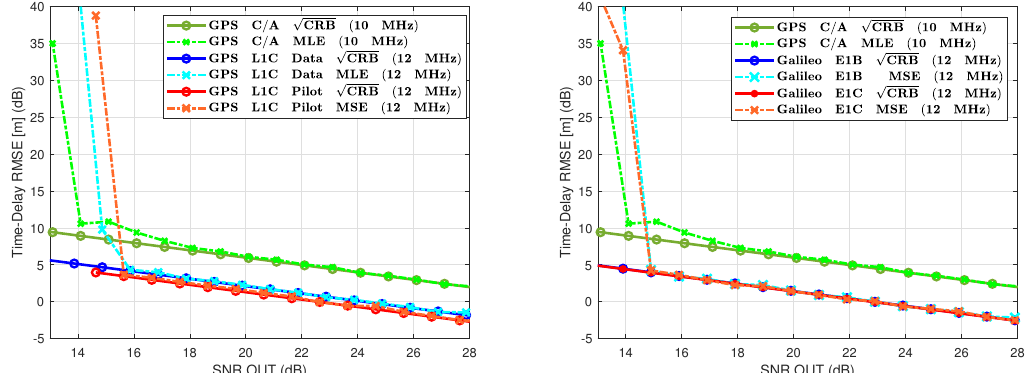
Figure 4. ( Left ) CRB/MLE for GPS L1 C/A BPSK(1), GPS L1C data component BOC(1,1), and GPS L1C pilot component TMBOC. ( Right ) CRB/MLE for GPS L1 C/A BPSK(1), Galileo E1B CBOC( + ), and Galileo E1B CBOC( −